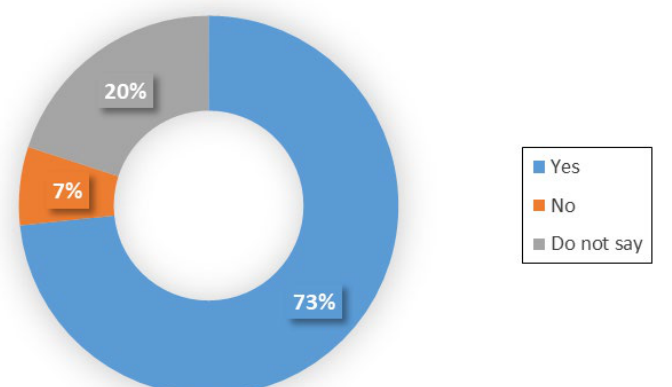
Figure 5. ISO 27001 is an excellent framework for compliance with